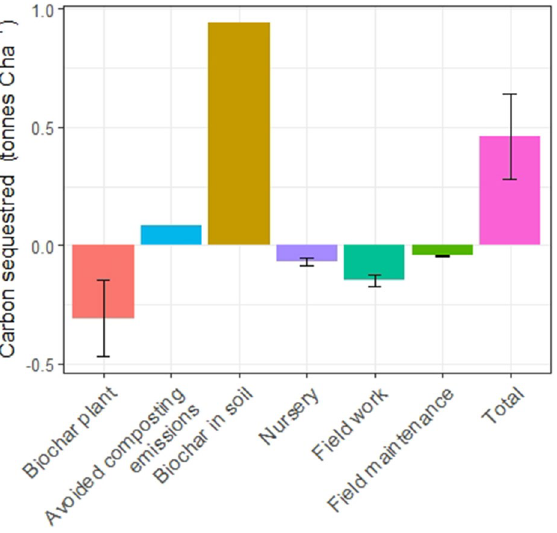
Figure 6. Grouped contribution analysis of the emission and emission reduction associated with reforesting one hectare from our case study plot including one year maintenance. The error bars represent ± 1 SD.